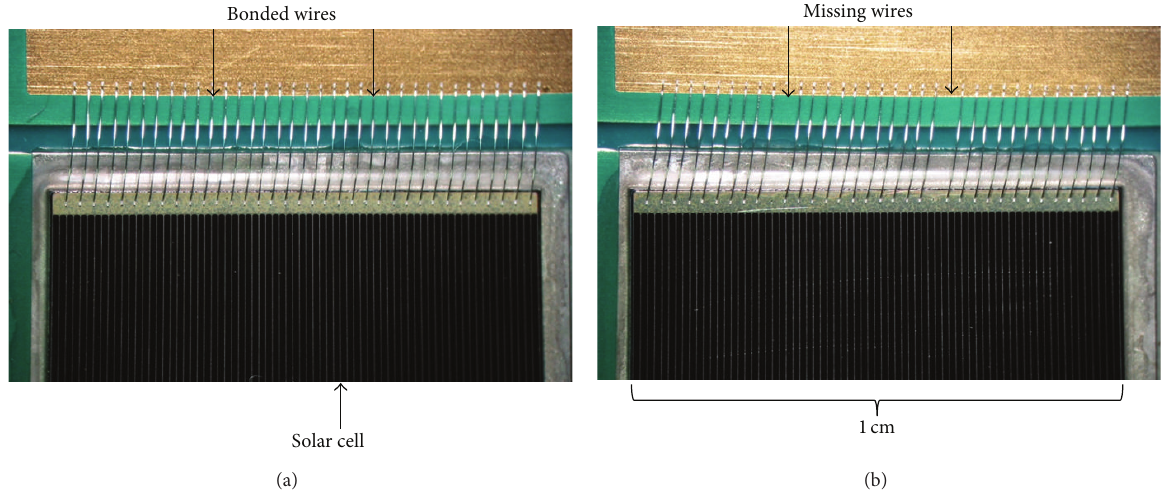
Figure 17: A completely bonded cell’s tab (a) and a cell’s tab with two missing wires